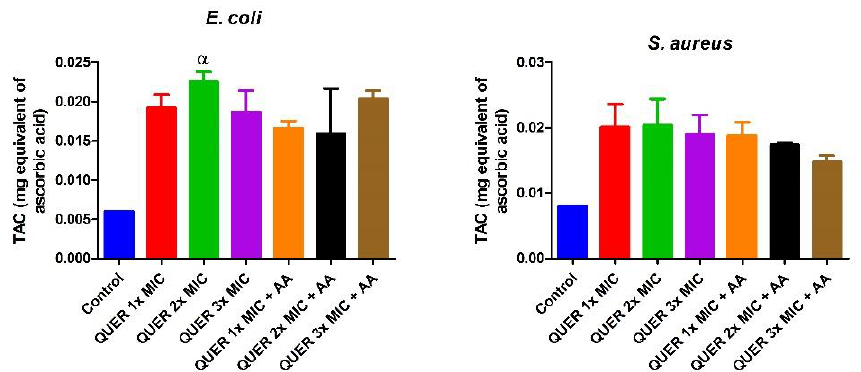
Figure 5. The total antioxidant capacity (TAC) of bacterial isolates following exposure to quercetin (QUER) alone or when combined with ascorbic acid (AA). Results are presented as an average of duplicate biological experiments (n = 2) with the corresponding standard error of the mean (SEM). Relative to the control, α at p < 0.05 is significant.